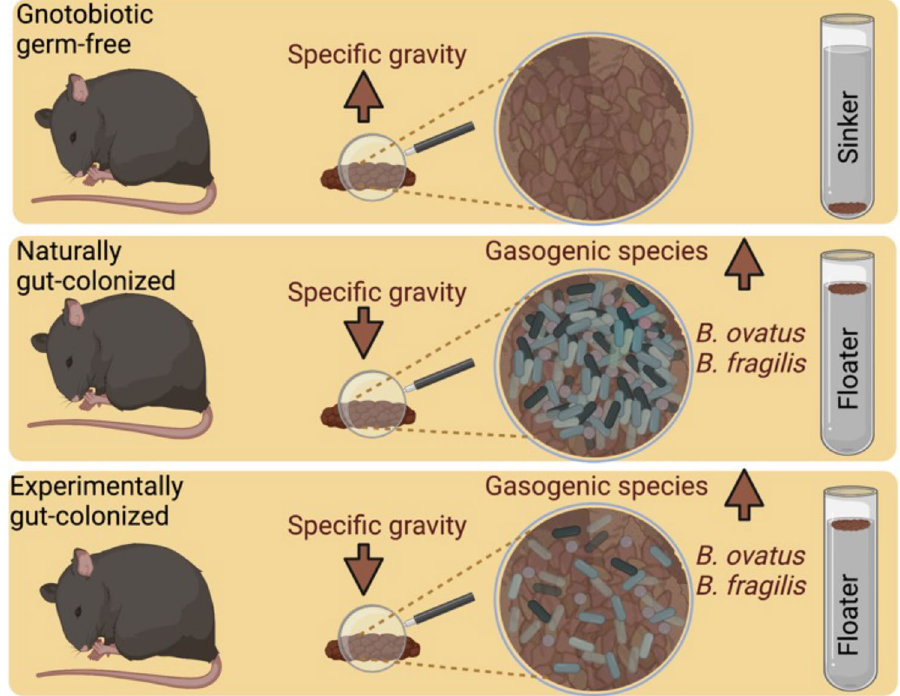
Figure 9. Illustration showing the role of gut microbial influence on fecal floatation in mice. The illustration was created using in